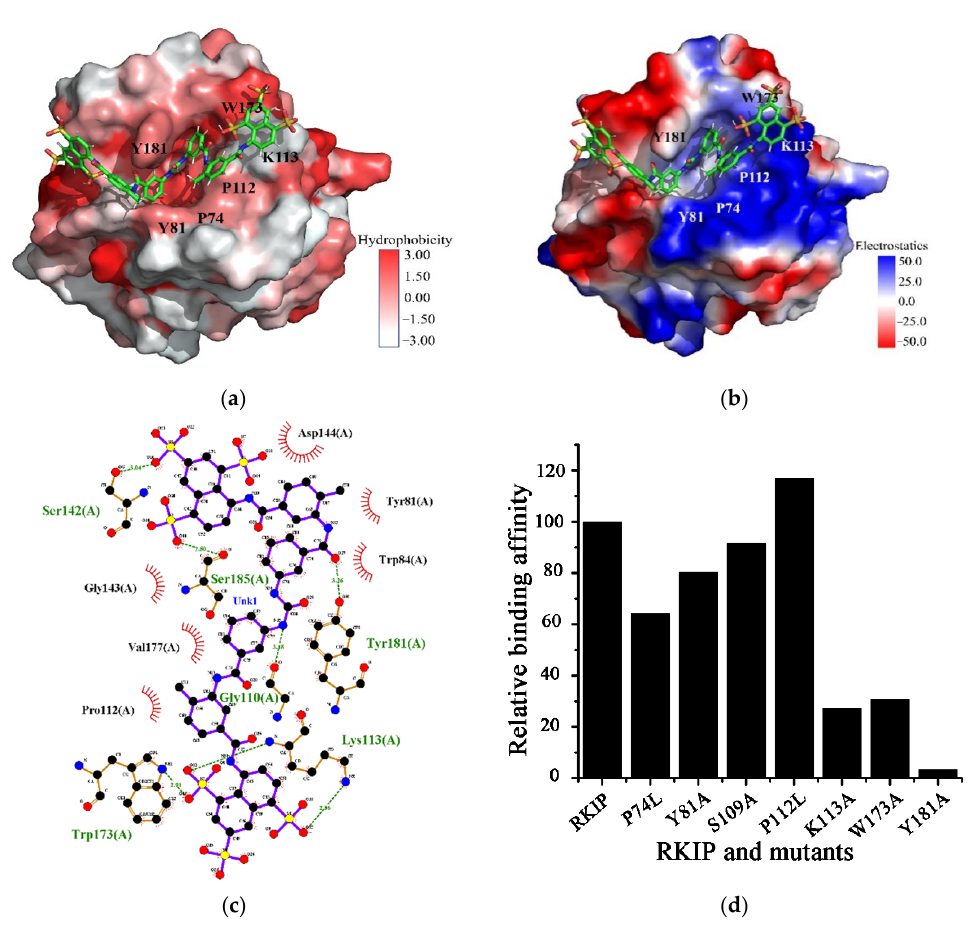
Figure 3. The key residues for hRKIP binding suramin. ( a , b ) Structural model of the hRKIP-suramin complex established by using the molecular docking approach based on the identified binding sites. The 3D structure of suramin is shown as sticks in red. Figures were generated by PyMOL. ( a ) Surface hydrophobicity of hRKIP; ( b ) Electrostatic surface of hRKIP. ( c ) Interactions between hRKIP and suramin produced by Ligplot based on the docked structural model of hRKIP-suramin. ( d ) Relative affinities of suramin binding to the mutants relative to hRKIP. The affinity of hRKIP was set to 100. Table 1. BLI-derived kinetic parameters describing the interactions of suramin with hRKIP and its mutants. Protein